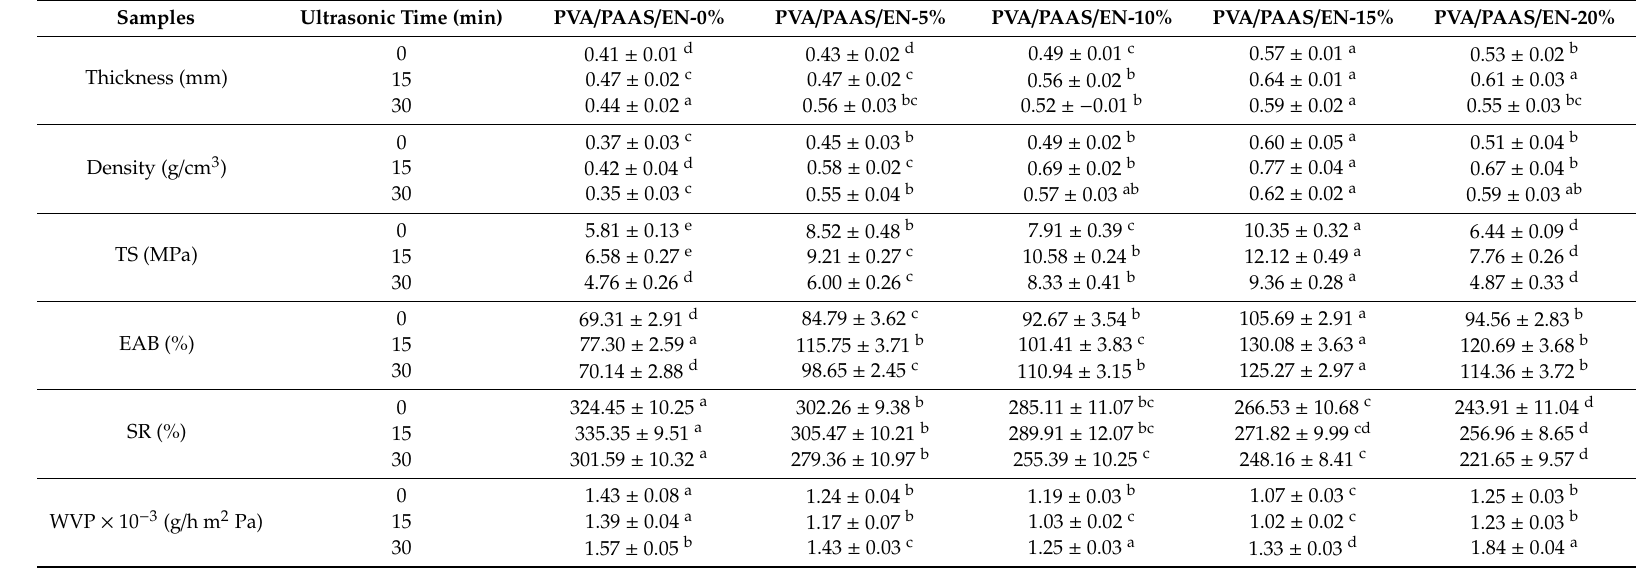
Di ff erent letters in the same column indicate significant di ff erences ( p <